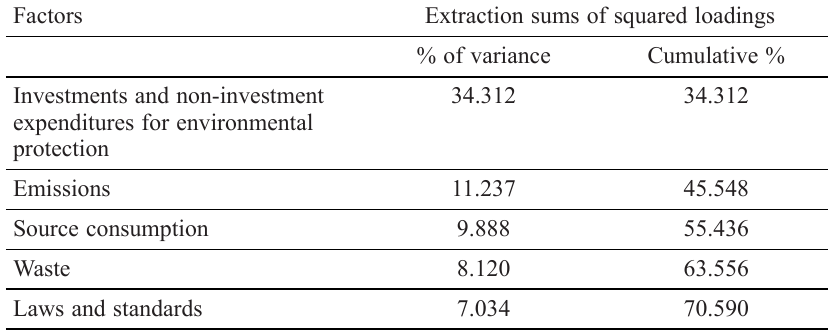
Table 1. Percent of variance explained by factors underlying the extension contents Factors